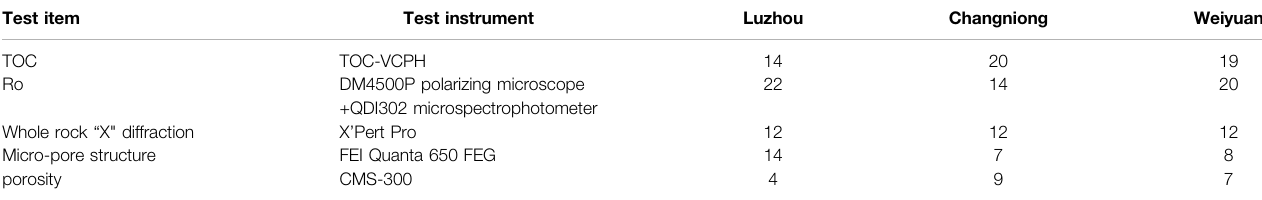
TABLE 1 | Samples and test instruments for shale organicization and pore